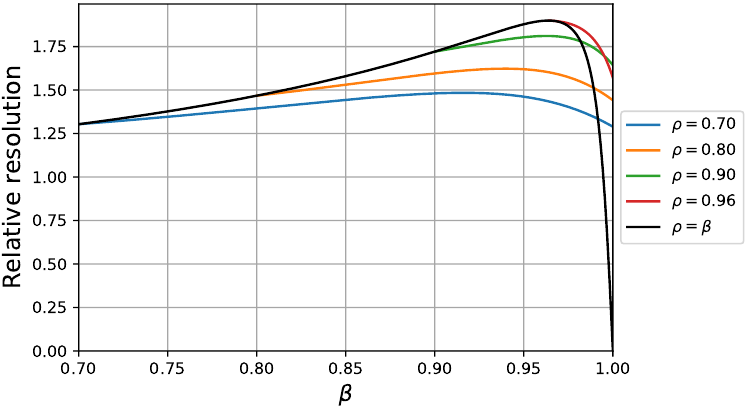
Figure 4. Relative resolution plotted against β at different values of ρ